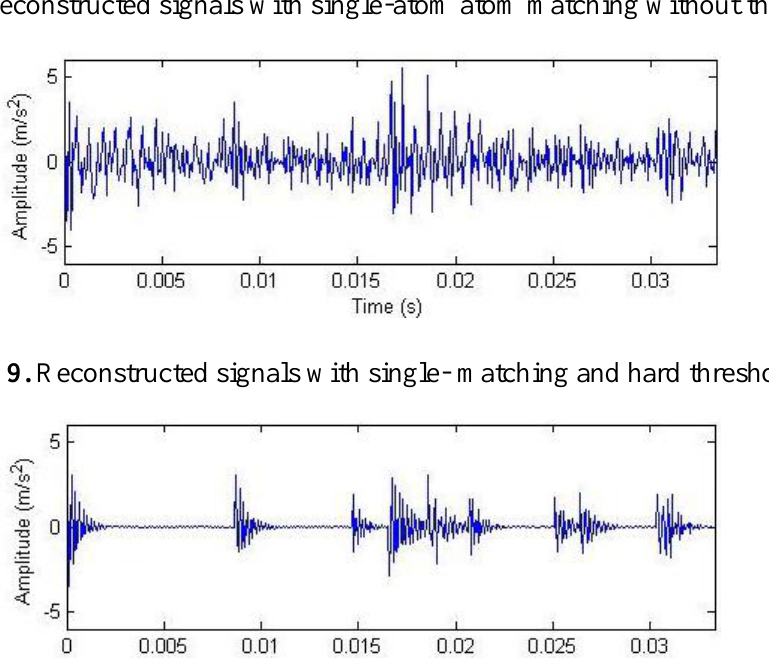
Figure 8. Reconstructed signals with single-atom atom matching without threshold.